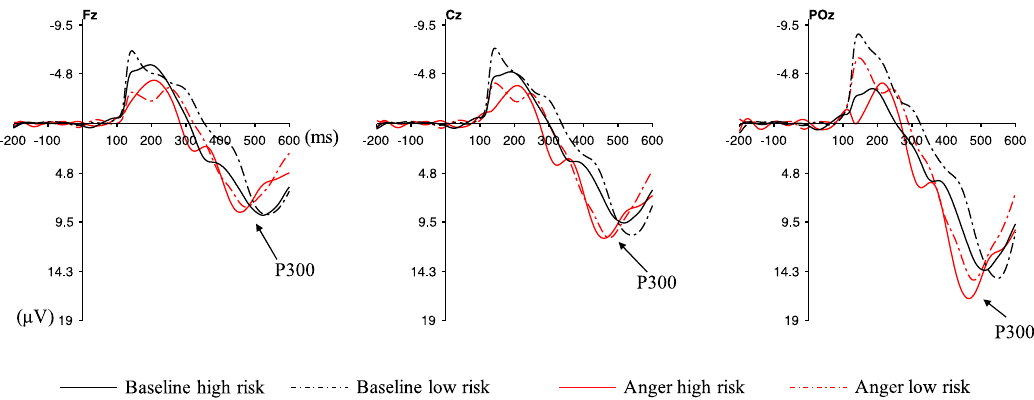
Figure 5. Waveforms of averaged event-related potentials (ERPs) for high- and low-risk choices in the electrodes of Fz ( left ), Cz ( middle ), and POz ( right ). Note: The feedback stimulus onset occurred at time 0. P300 was calculated from 400 ms to 500 ms after the feedback onset. Negative was plotted up.